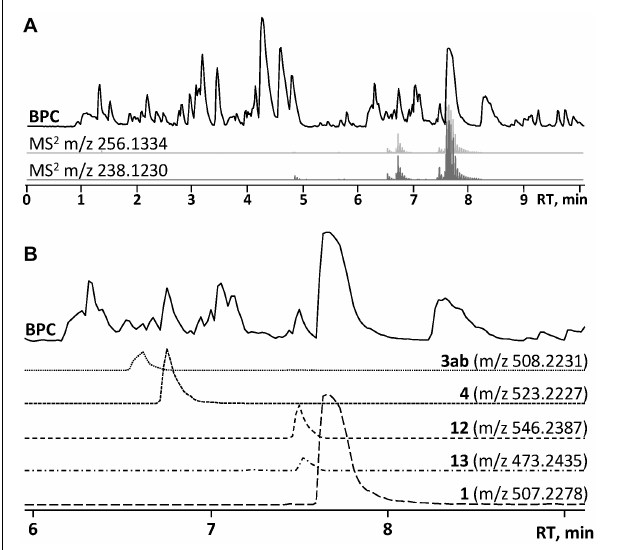
FIGURE 3 | HPLC-MS analysis for asperphenamate analog production on YES media. (A) Base peak chromatogram (BPC) of crude P. astrolabium extract, with extracted ion chromatogram (EIC) showing “bait” ions m/z 256.1334 and m/z 238.1230. (B) Zoomed BPC with EIC for asperphenamate analogs at full